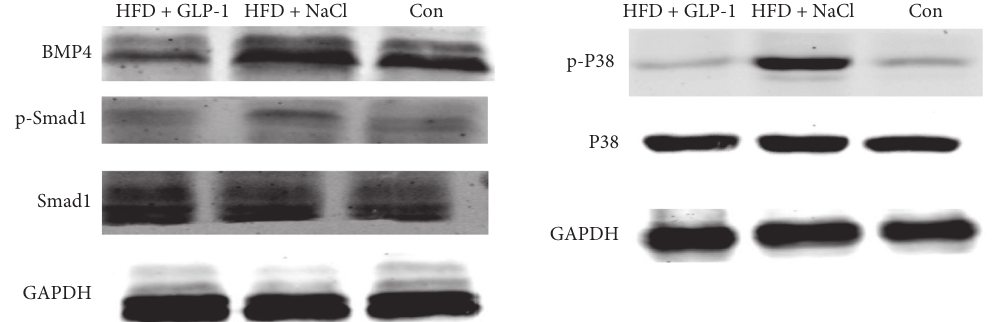
Figure 6: Protein expression of BMP4 and related signaling pathway in liver. Group A: HFD+GLP-1; Group B: HFD+NaCl; Group C: Con. BMP4: bone morphogenetic protein